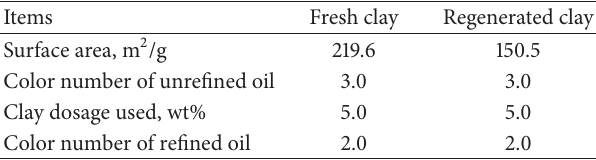
Figure 7: Effect on the surface area of extraction number. Table 6: Characterization of regenerated clay.